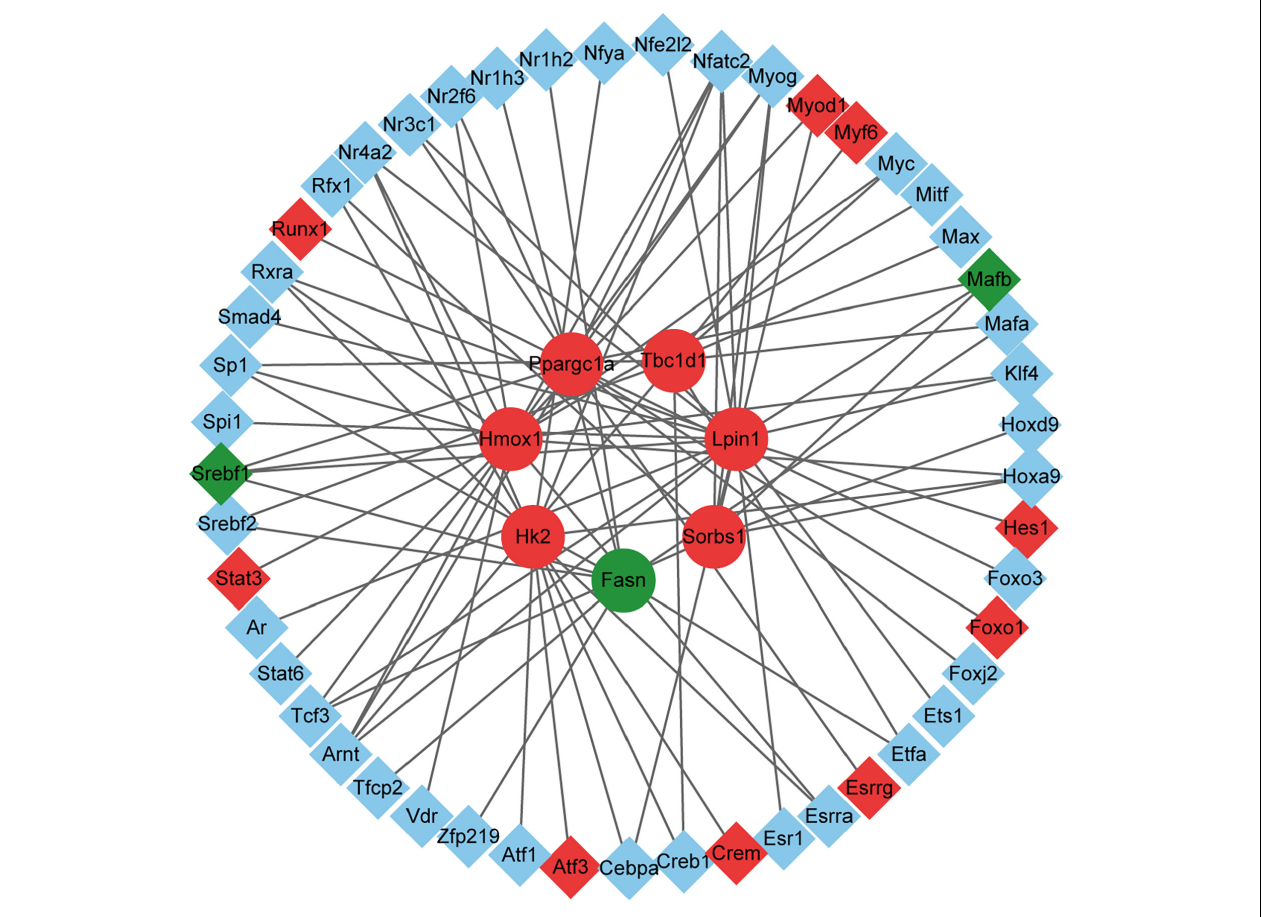
FIGURE 6 | The network of DEGs and their corresponding TFs. The circles represent the target genes of the TFs, and the diamonds represent the TFs. Red indicates significantly upregulated, green indicates significantly downregulated, and blue indicates the expression of genes without significant